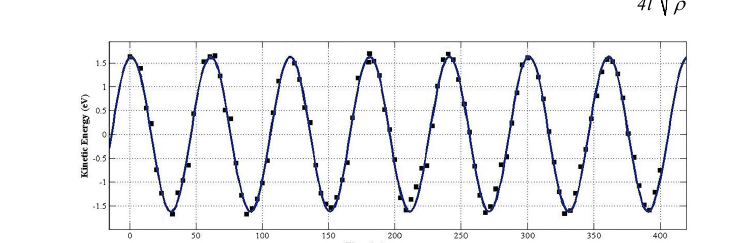
Figure 7. Schematic view of an armchair SWSiNT with C-F boundary conditions (a) minimized energy and (b) after initial transverse deflection.